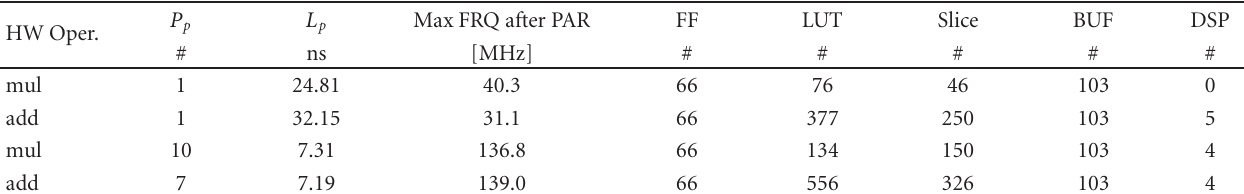
Table 2: Excerpt from metrics requested by the candidate estimation process from PivPav circuit library for the XC4VFX100-FF1152-10 FPGA device.